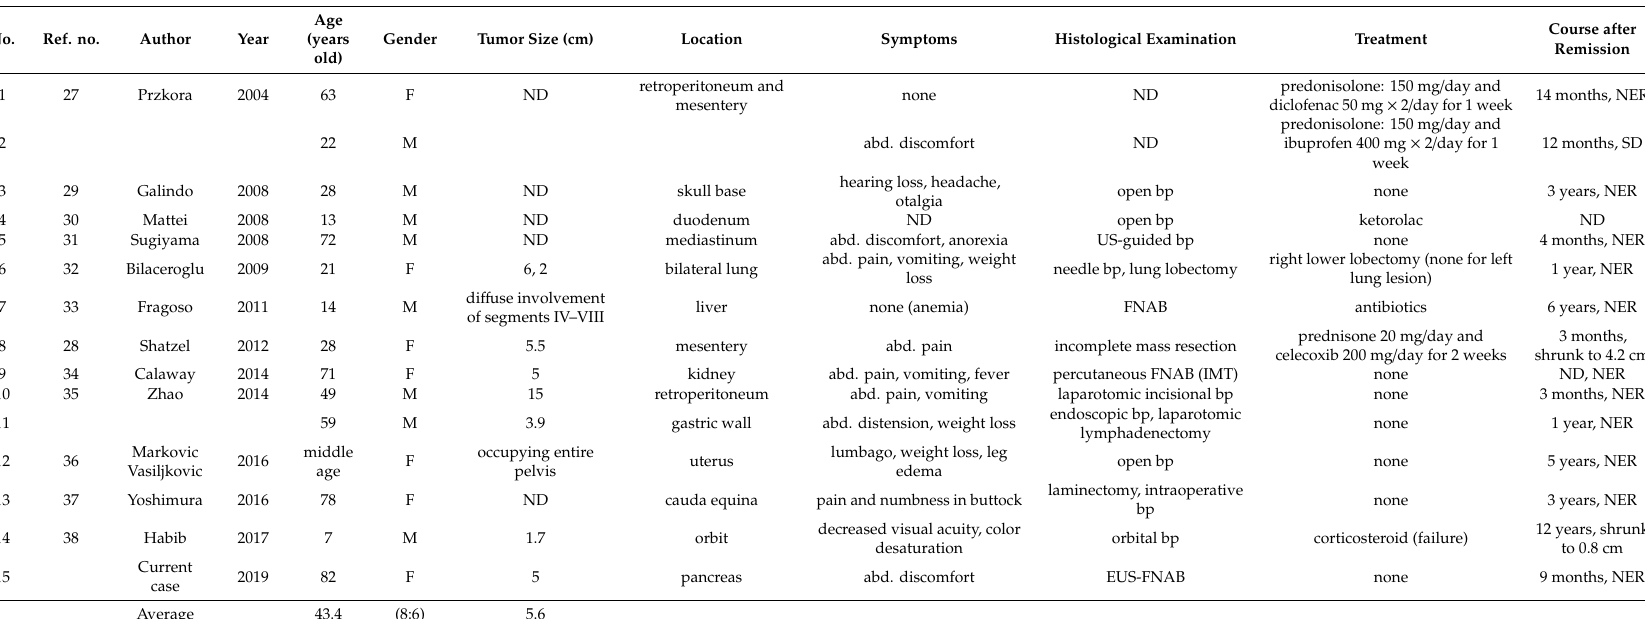
Table 2. Reported cases of inflammatory fibroblastic tumor (IMT) with spontaneous and / or drug-used remission (English literature). No. Ref.